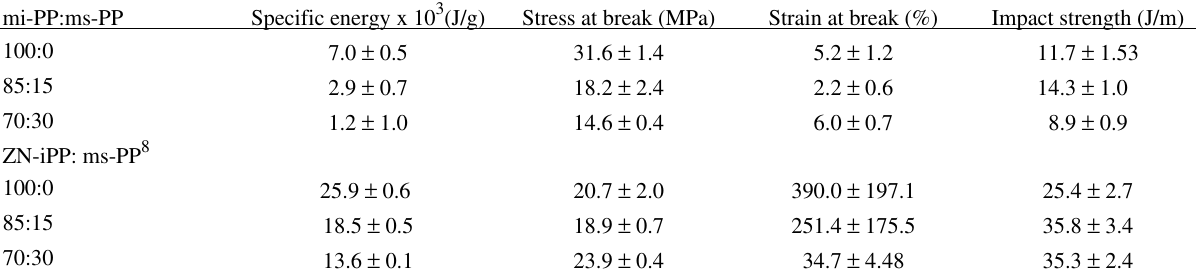
Table 3. Influence of ms-PP addition on the processability and mechanical properties of metallocenic mi-PP. mi-PP:ms-PP